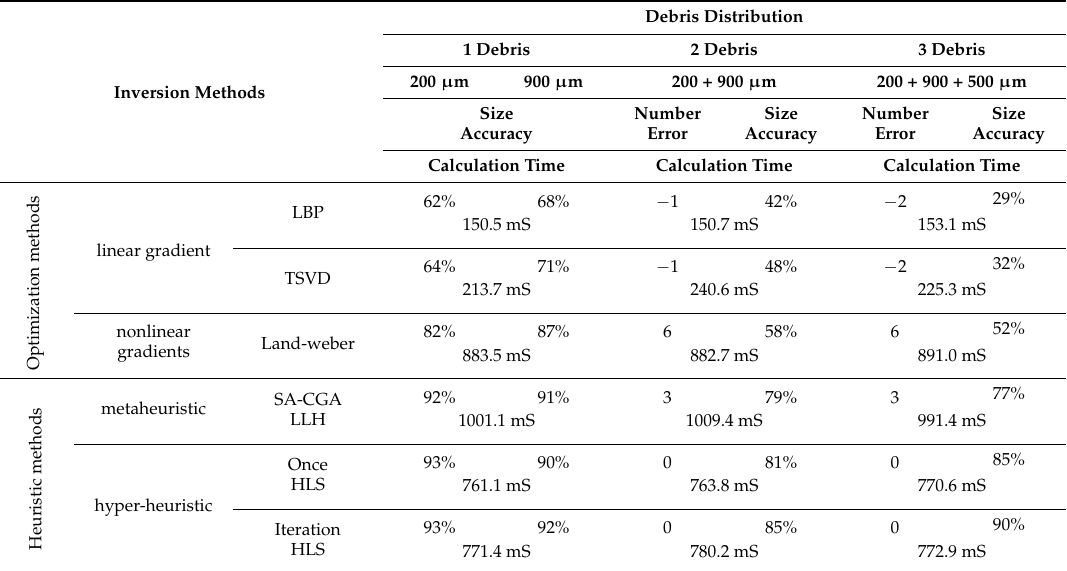
Table 3. Comparisons of